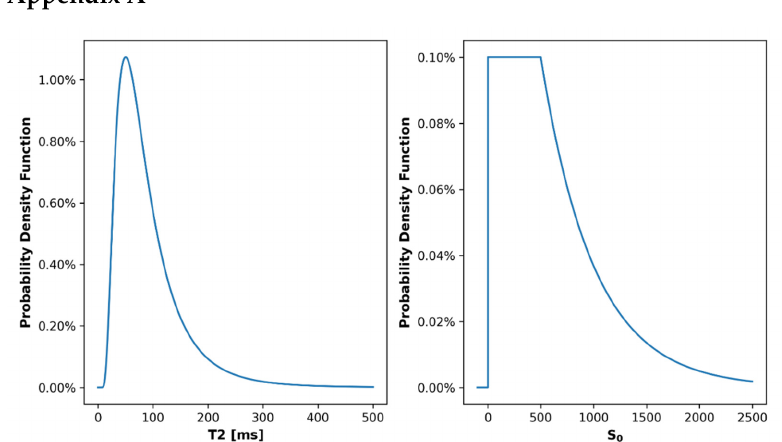
Figure A1. Visualization of the probability density distributions used to sample T2 relaxation times and signal intensities ( S 0 ) for the synthetic dataset. The T2 relaxation times were sampled from a log-normal distribution with z = x − 5 and probability density function 70 (cid:18) (cid:19) 2 1 − ln ( z ) √ f ( z ) ∼ 1 exp . The signal intensities followed a customized probability den- 70 2 · 0.66 2 0.66 x 2 π sity function f ( x ) , which was defined as: f ( x ) = 0 for x < 0; f ( x ) =